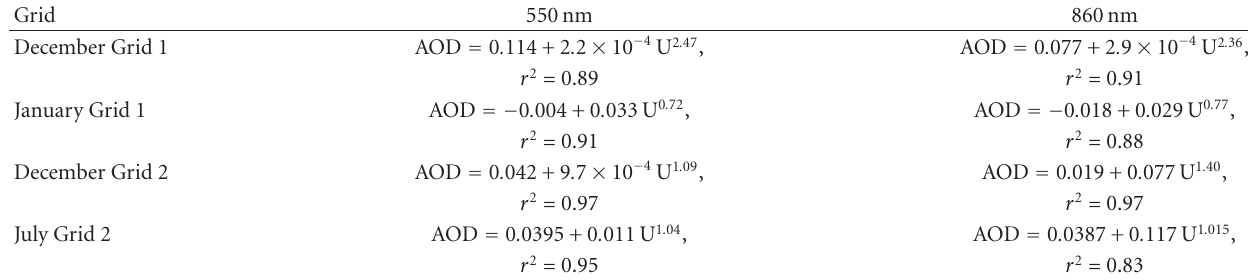
Table 1: Power-law fits for MODIS AOD versus wind speed for Grid 1 and Grid